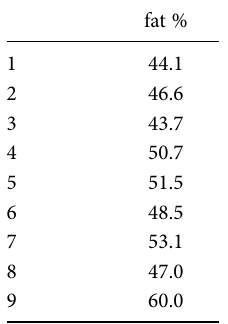
Table 4. Fat content as a per- centage of dry